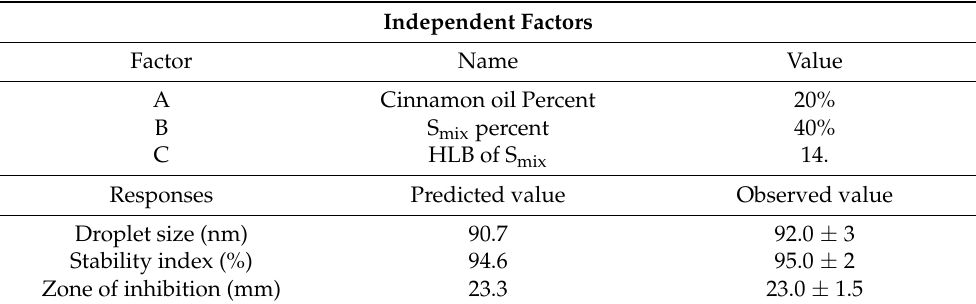
Table 4. Optimum formula suggested for the CO-NE formulation and the predicted and observed responses for the optimized